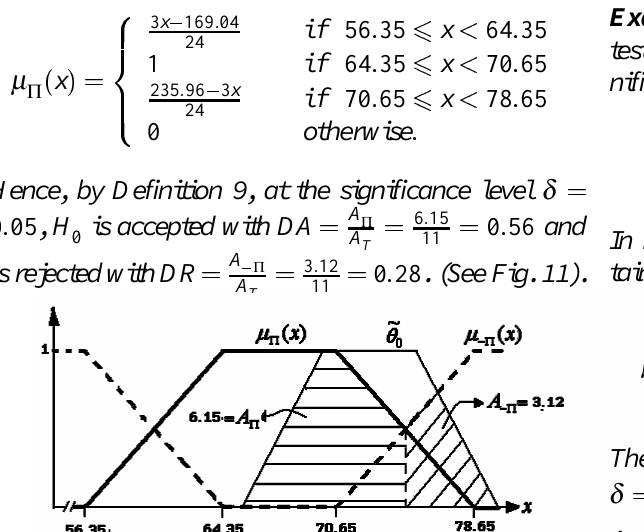
0 28). (cid:2) (cid:0)